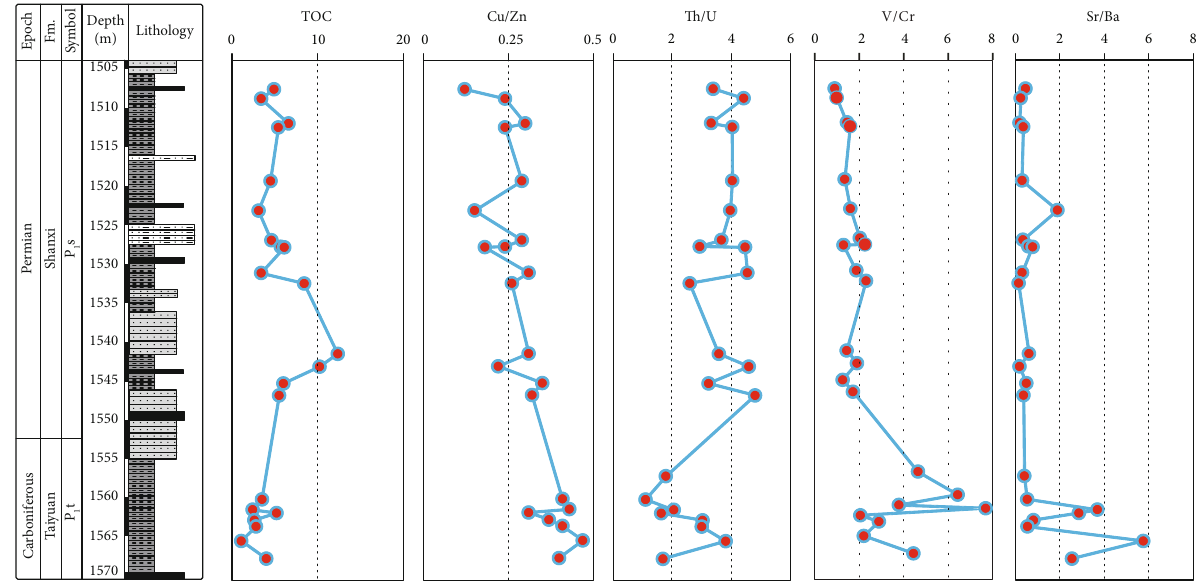
Figure 3: The stratigraphic distribution of TOC, redox proxies (Cu/Zn, Th/U, and V/Cr), and paleosalinity proxies (Sr/Ba) of the studied